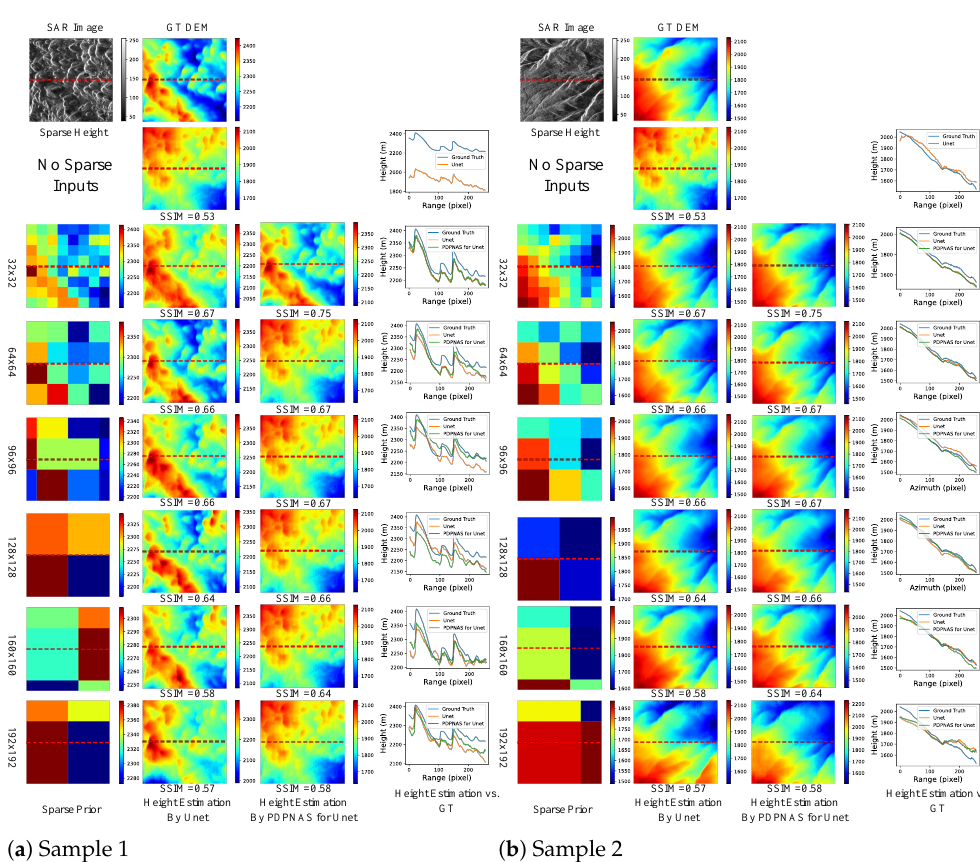
Figure 13. Two local estimated height maps with various sparsity in Guiyang datasets. Comparison experiments between Unet with and without PDPNAS are also shown in the figure. The down- sampling factors are 32 × 32, 64 × 64, 96 × 96, 128 × 128, 160 × 160, and 192 × 192, respectively. Elevation lines along range directions with a fixed middle azimuth value marked by red dash lines in the figures are plotted in 4th and 8th columns respectively.